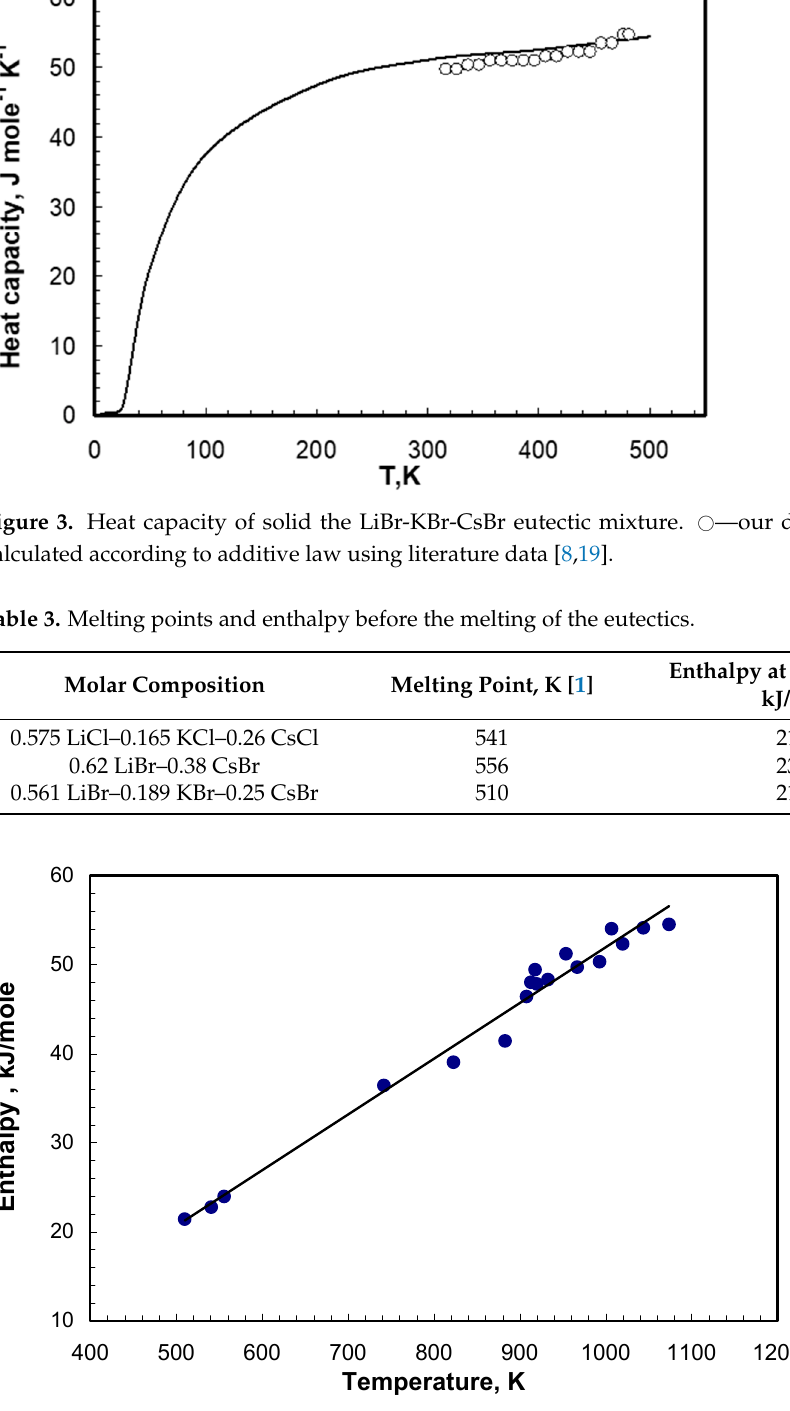
Figure 4. Enthalpy of salts and eutectics before melting versus melting point. Table 3. M elting points and enthalpy before the melting of the eutectics. Molar Composition